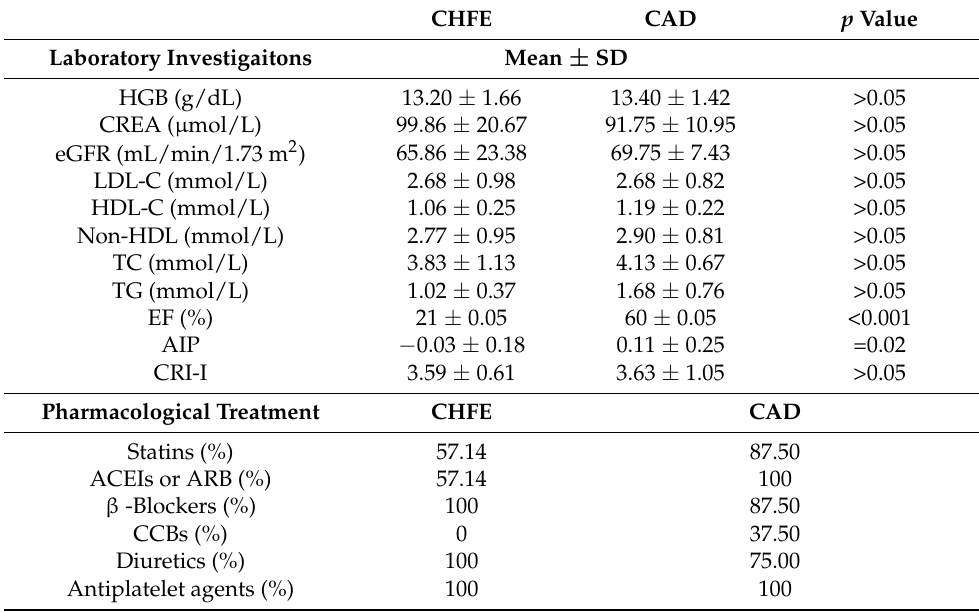
Table 5. Laboratory and pharmaceutical data of patients with chronic heart failure exacerbations (CHFE) or coronary artery disease